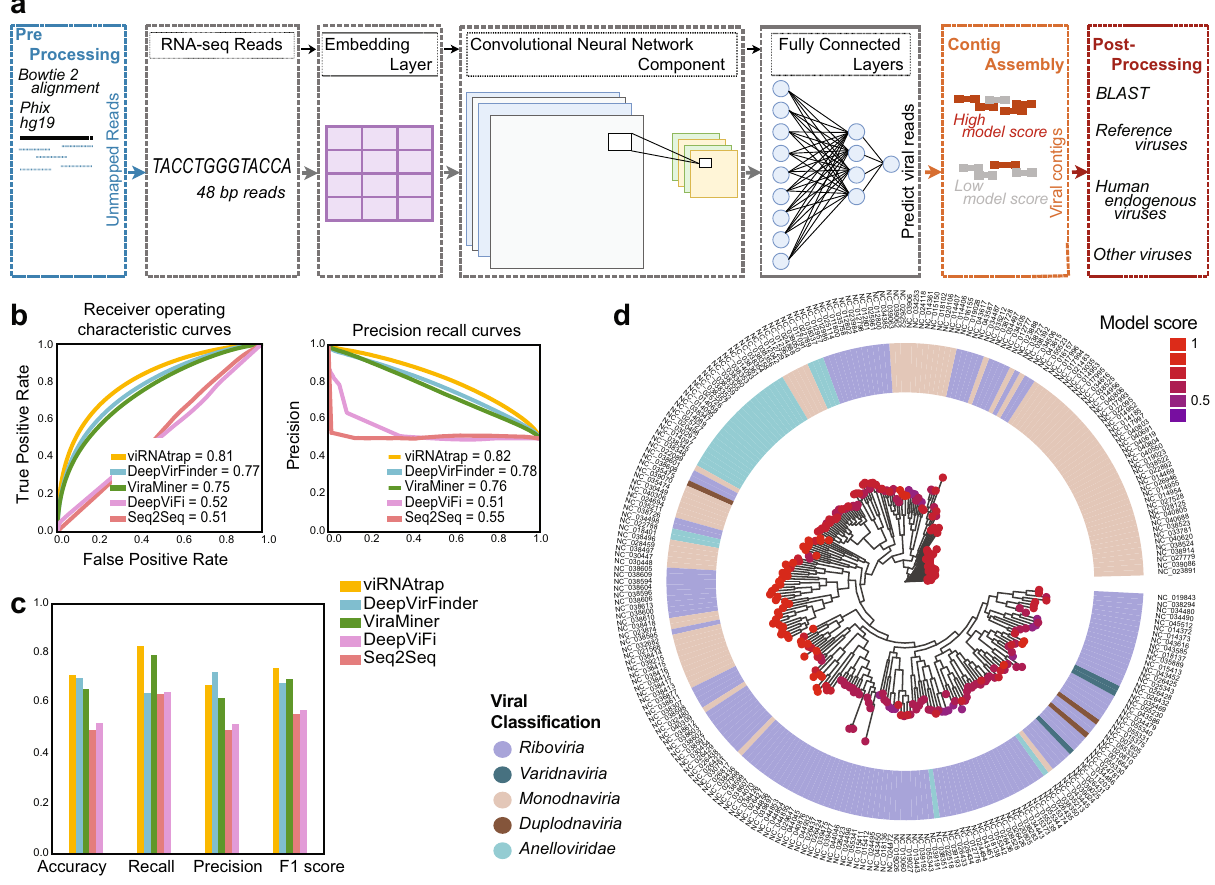
Fig. 1 | Training and evaluation of the viRNAtrap framework. a A schematic overview of the viRNAtrap framework. Unmapped reads were extracted and given asinputtotheneuralnetwork,toextracttheviralreadsandassembleviralcontigs, thatwerecomparedagainstthreeviraldatabasesusingblastn. b Receiveroperating characteristic and precision-recall curves showing the model performance when viRNAtrapandmodelsusedforcomparisonwereappliedtothetestset. c Barplots